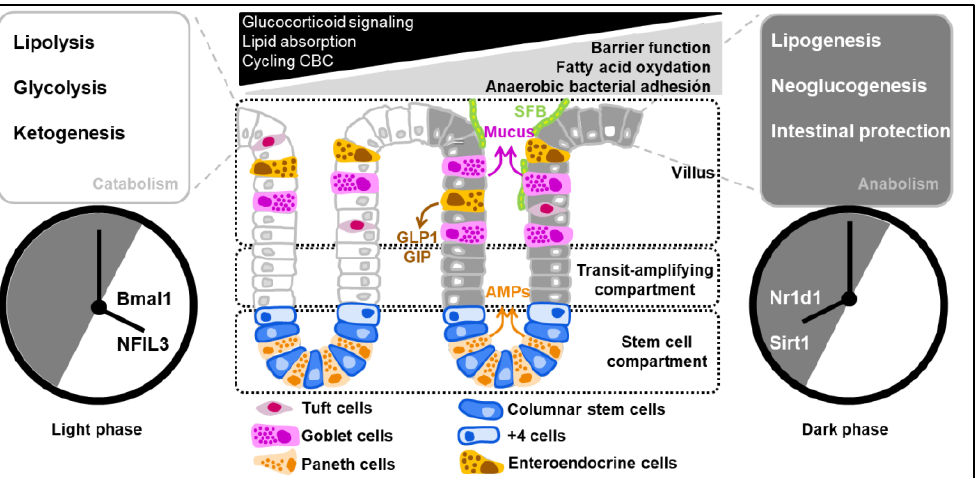
Figure 2. Diurnal oscillations of the clock-controlled genes regulate the catabolism and anabolism of intestinal epithelial cells. Clock-controlled genes are regulated by a complex interplay of positive and negative loops within the framework of the solar day. As an example, Period 2 is thought to be repressed by the bZIP transcription factor NFIL3 that is negatively regulated when the expression of Nr1d1 (the gene that codifies Rev-erb alpha) reaches its zenith.